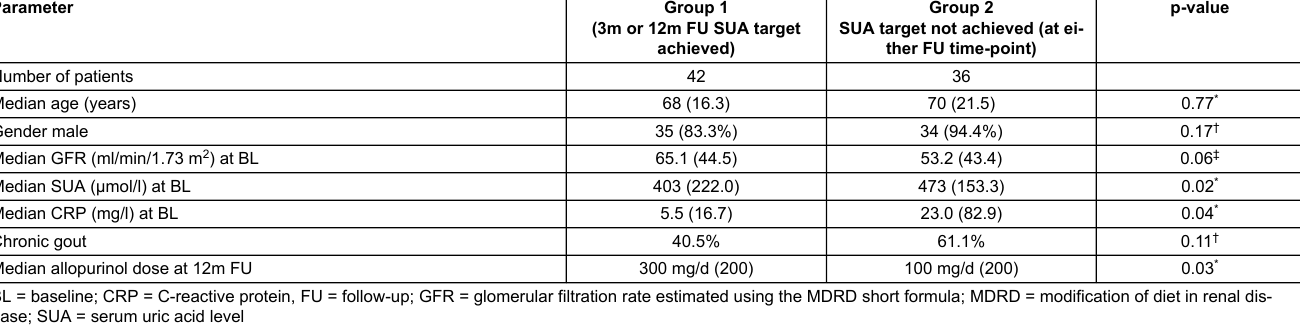
Table 2: Comparison of serum uric acid target level achieved or not (and no concomitant flare at follow-up).